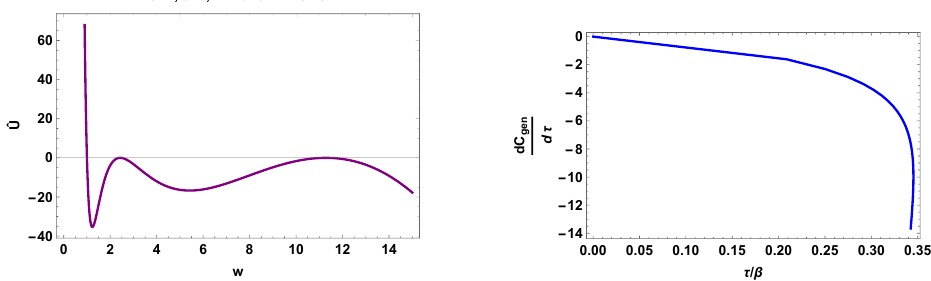
Figure 19 . The case d = 4 , θ = 0 , z = 2 and λ = − 0 . 25 : Left ) The effective potential as a function of w . For this value of λ , there are two maxima w are the solutions to equation A ( λ, w ) = 0 . Right ) The growth rate d C gen negative and a decreasing function of τ/β , and hence it is not